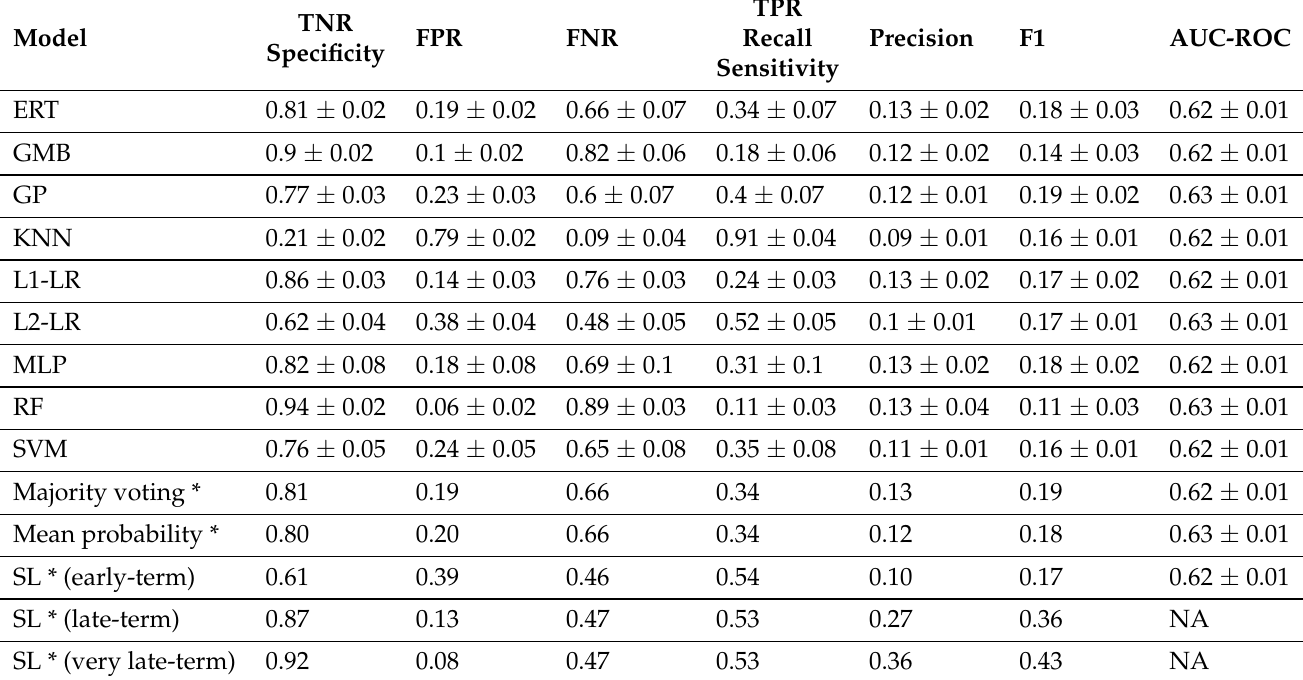
Table 4. Performance of the nine individual ML models in our study, three ensemble learners, and prospective validations for prediction of early-, late-, and very late-term TLF. * = calculated on sum of confusion matrices. NA = AUC-ROC is not measurable for these two-step follow-up